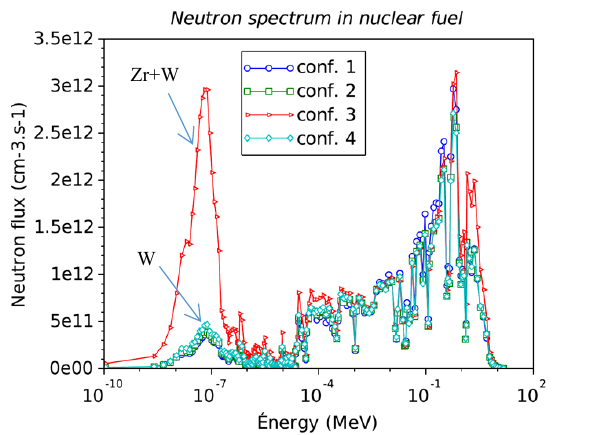
Fig. 5. The neutron spectrum in the fuel sample for each device configuration.